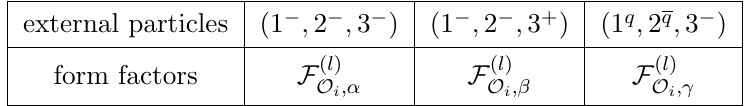
Table 1 . Notation of form factors with three partons, where (cid:6) indicates positive or negative helicity